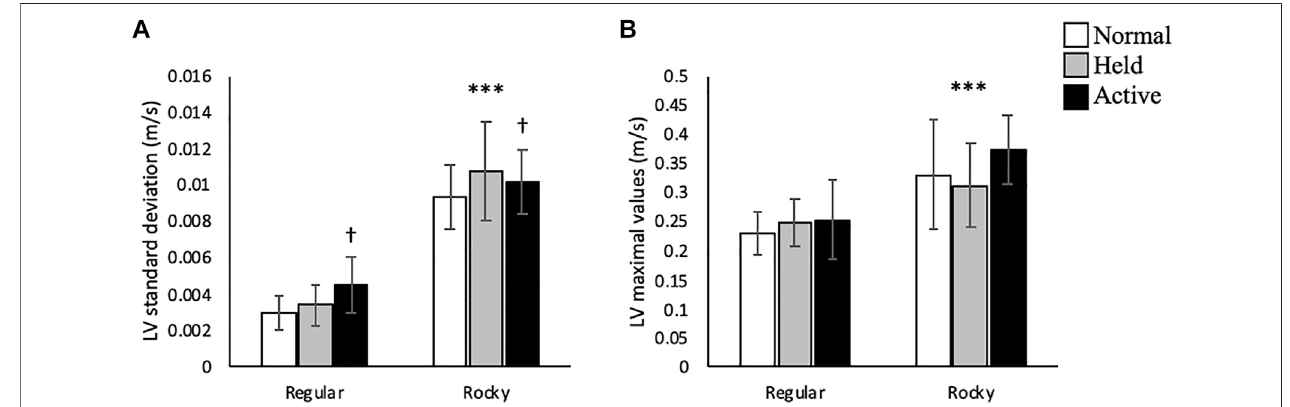
FIGURE7| Trunk linearvelocity (A) standarddeviation(m/s) and (B) maximalvalues(m/s) accordingtosurfacetypeforeach armconditioninthevertical direction, *** shows that rocky surface led to larger values than regular surface at p < 0.001 while † shows that active arm swing led to larger values than normal arm swing at p < 0.05.